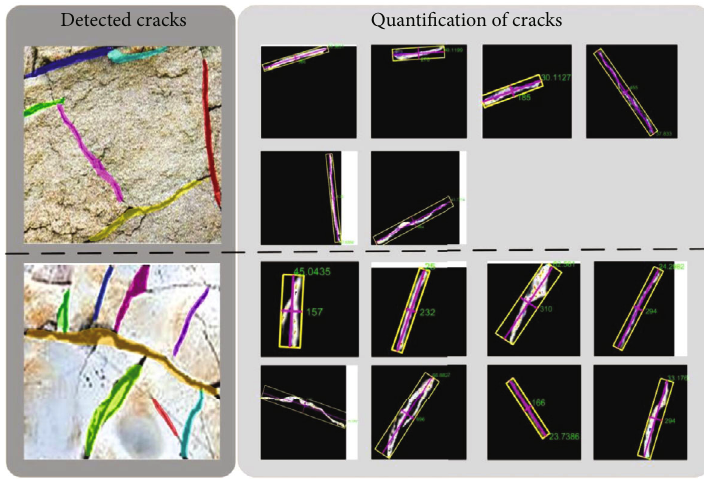
Figure 21: Example results of the proposed method for crack quanti fi